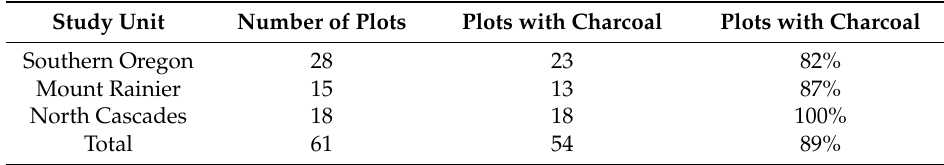
Table 1. Proportion of plots within study units that contained charcoal.